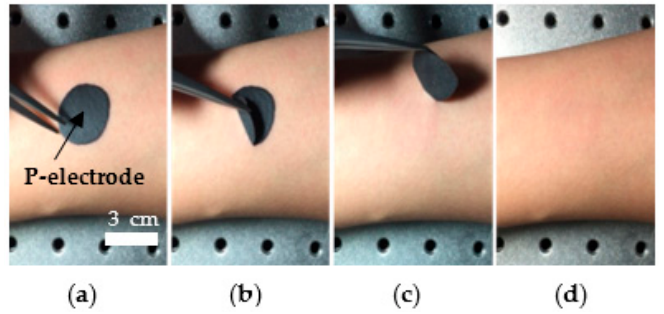
Figure 5. Easy removal of the P-electrode from the skin. ( a ) P-electrode formed on skin; ( b , c ) manual removal of the P-electrode from skin; and ( d ) the skin right after the detachment of the P-electrode.